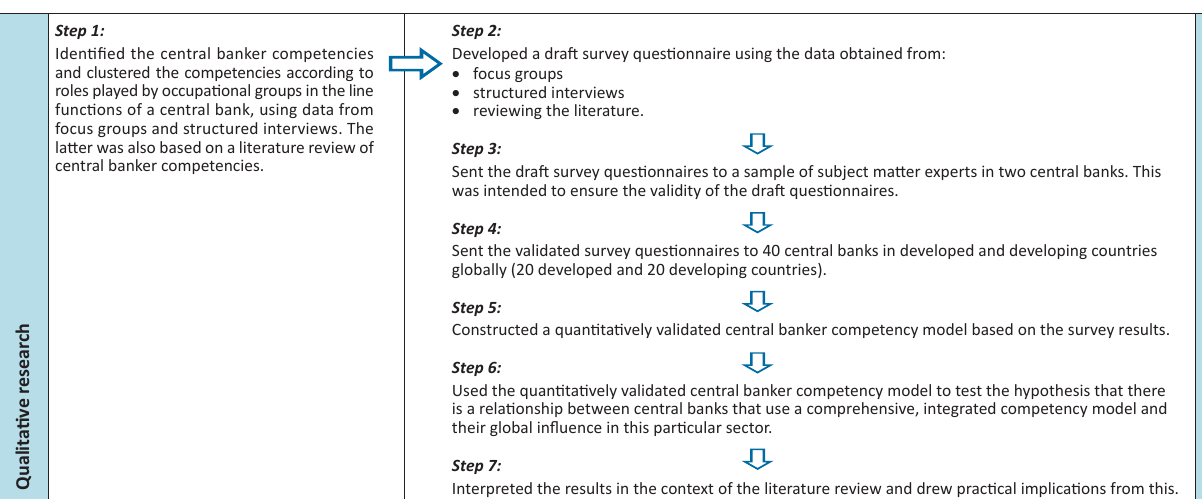
FIGURE 2: The blended research approach used in this